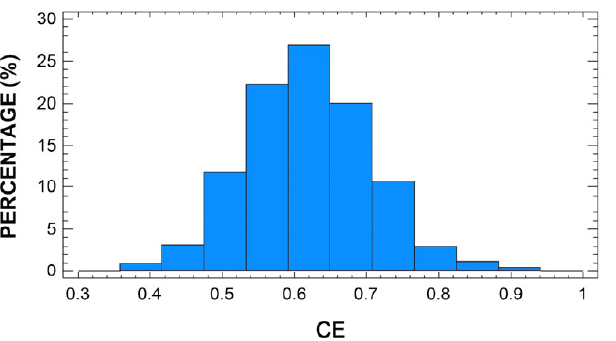
Figure 1. Frequency distribution (histogram) of curd efficiency (CE) in Manchega sheep milk ( n = 967).